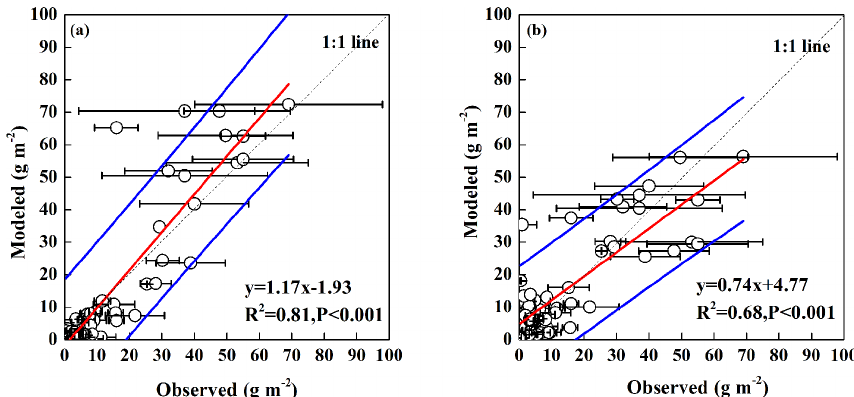
Figure 2. Regression of simulated against observed total amount of seasonal/annual CH 4 emissions from global wetland sites by CH4MOD wetland (a) and TEM (b) . The horizontal bars are the standard errors from the sampling replicates at the wetland site. The red line is the regression line of simulated vs. observed between modeled and observed values. The blue line is the prediction correspondence. The dashed line is the 1:1 line. Table 2. Model performance for CH4MOD wetland and TEM for different continents and wetland types. Wetland type CH4MOD wetland TEM n or continent R 2